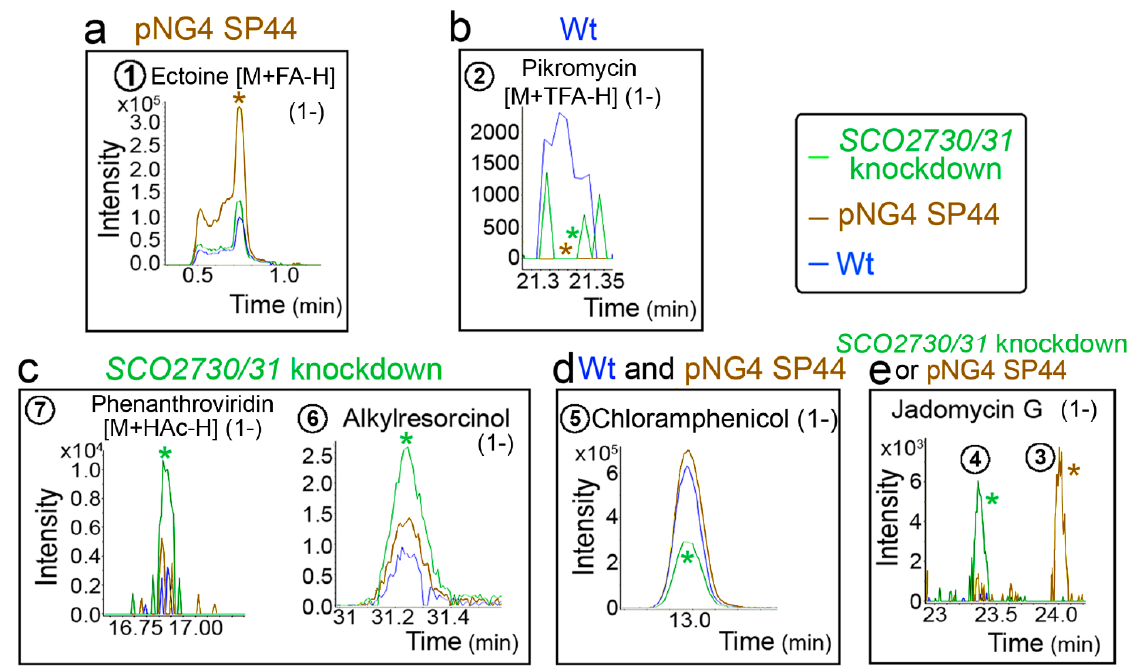
Figure 6. HPLC-MS chromatograms of some of the identified secondary metabolite compounds, showing different abundance values in the S. venezuelae SCO2730/31 knockdown mutant compared to the S. venezuelae wild-type strain with and without pNG4-SP44. ( a ) Compound showing higher abundance in the S. venezuelae strain harbouring pNG4-SP44. ( b ) Compound showing higher abundance in the S. venezuelae wild-type strain. ( c ) Compounds showing higher abundances in the S. venezuelae SCO2730/31 knockdown mutant. ( d ) Compounds showing higher abundances in the S. venezuelae wild-type strain with and without pNG4-SP44. ( e ) Jadomycin G isomers detected in the S. venezuelae strain harbouring pNG4-SP44 and the SCO2730/31 knockdown mutant. Only one biological replicate is shown. The asterisks indicate significant differences. The numbers are as in Figure 5.